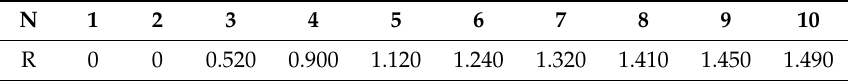
Table 2. Randomized index values corresponding to